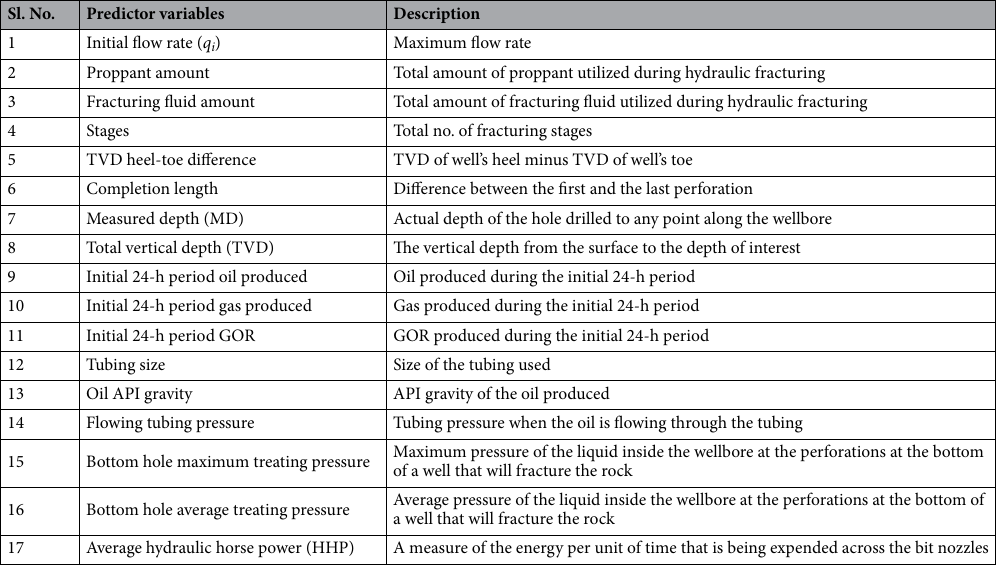
Table 2. Description of the predictor variables employed in the ML